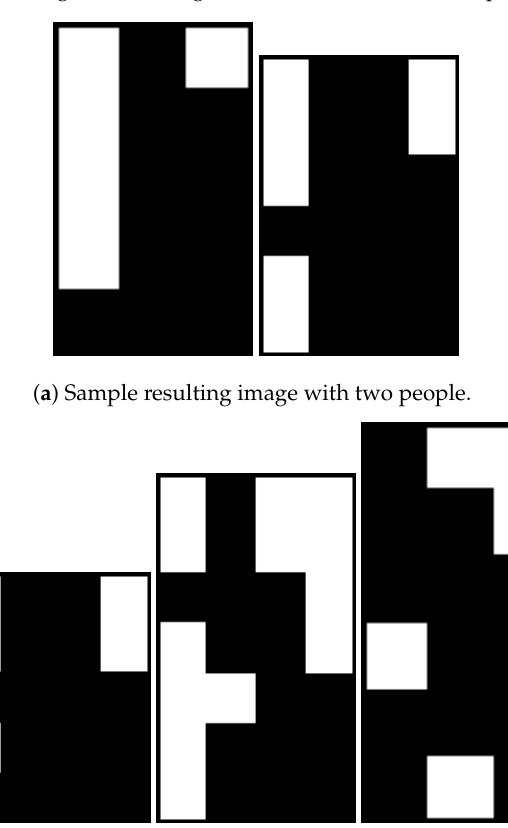
( a ) Sample resulting image with two people. ( b ) Sample resulting image three people. Figure 9. Sample images after background subtraction and multiple RoI extraction.